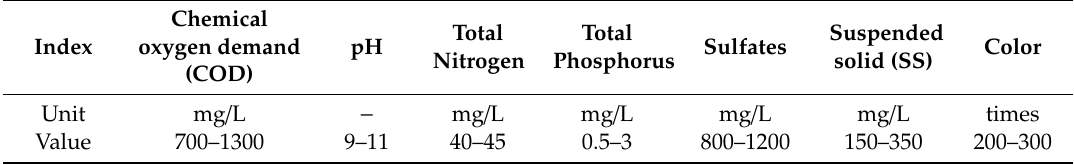
Table 2. Wastewater quality.